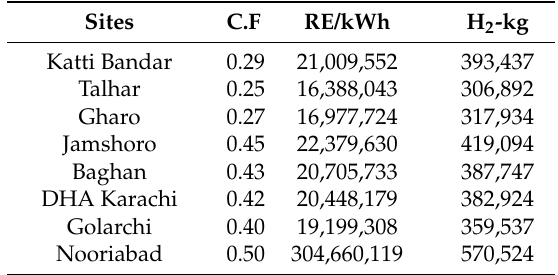
Table 6. Capacity factor, renewable energy and hydrogen